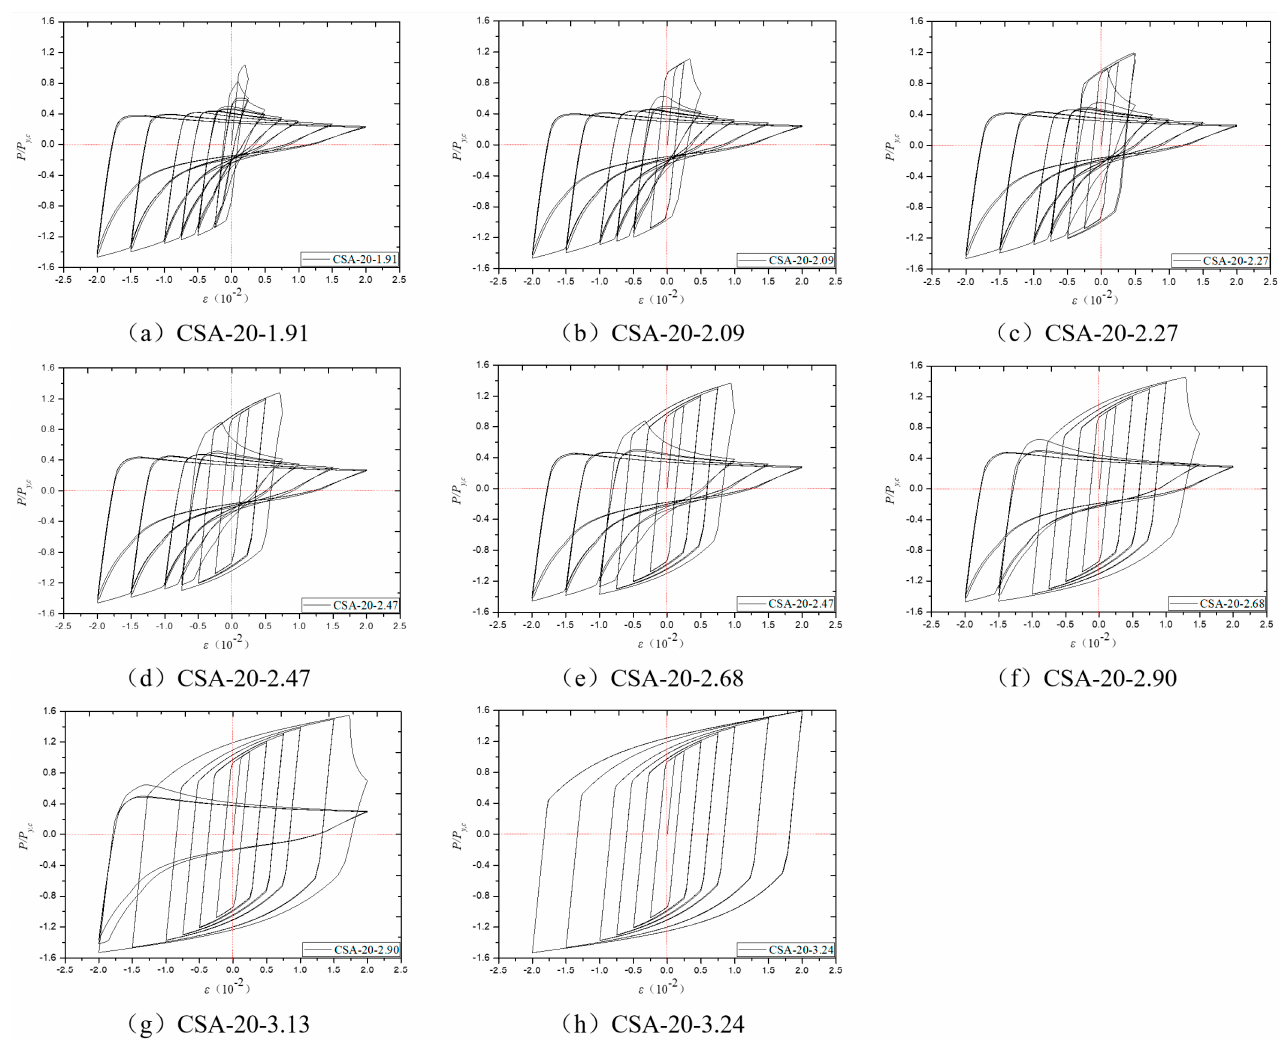
Figure 12. Hysteretic curves for numerical examples (No. 1) in Table